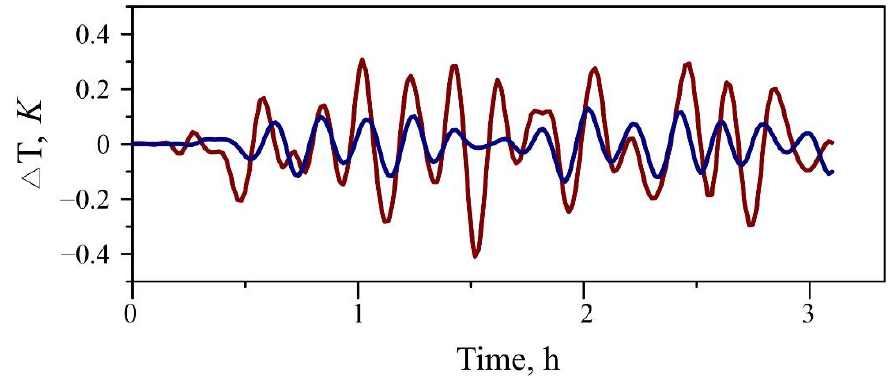
Figure 7. Temperature variations at an altitude of 300 km above the source (red line) and 500 km away to the left (blue line). The initial moment corresponds to the start time of calculations.